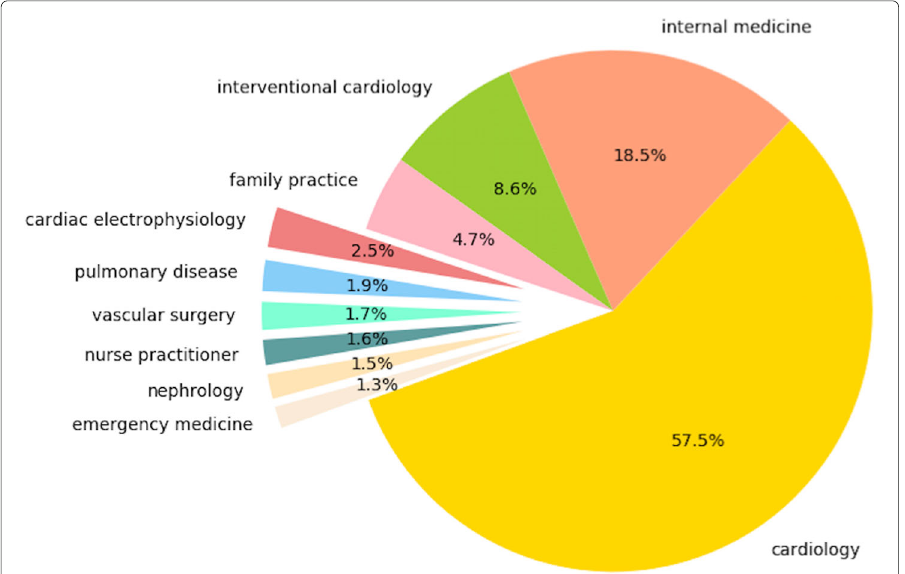
Fig. 4 Top 10 specialties as the most key physician on referral paths in 2007-2011. Each group accounts for more than 1% of key